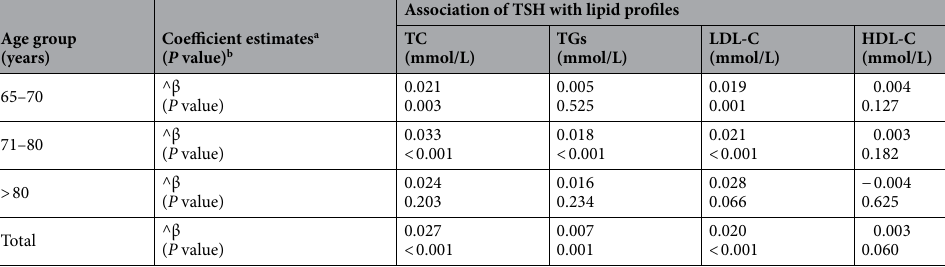
Table 5. Age-specific associations between TSH and lipid profiles in elderly people (n = 2460). TSH, thyroid stimulating hormone; TC, total cholesterol; TGs, triglycerides; LDL-C, low density lipoprotein cholesterol; HDL-C, high density lipoprotein cholesterol. a Multiple linear regression analysis on the association between TSH and lipid profiles after adjusting for age, gender, height, weight, BMI and HbA1c. b P value < 0.05 is considered statistically